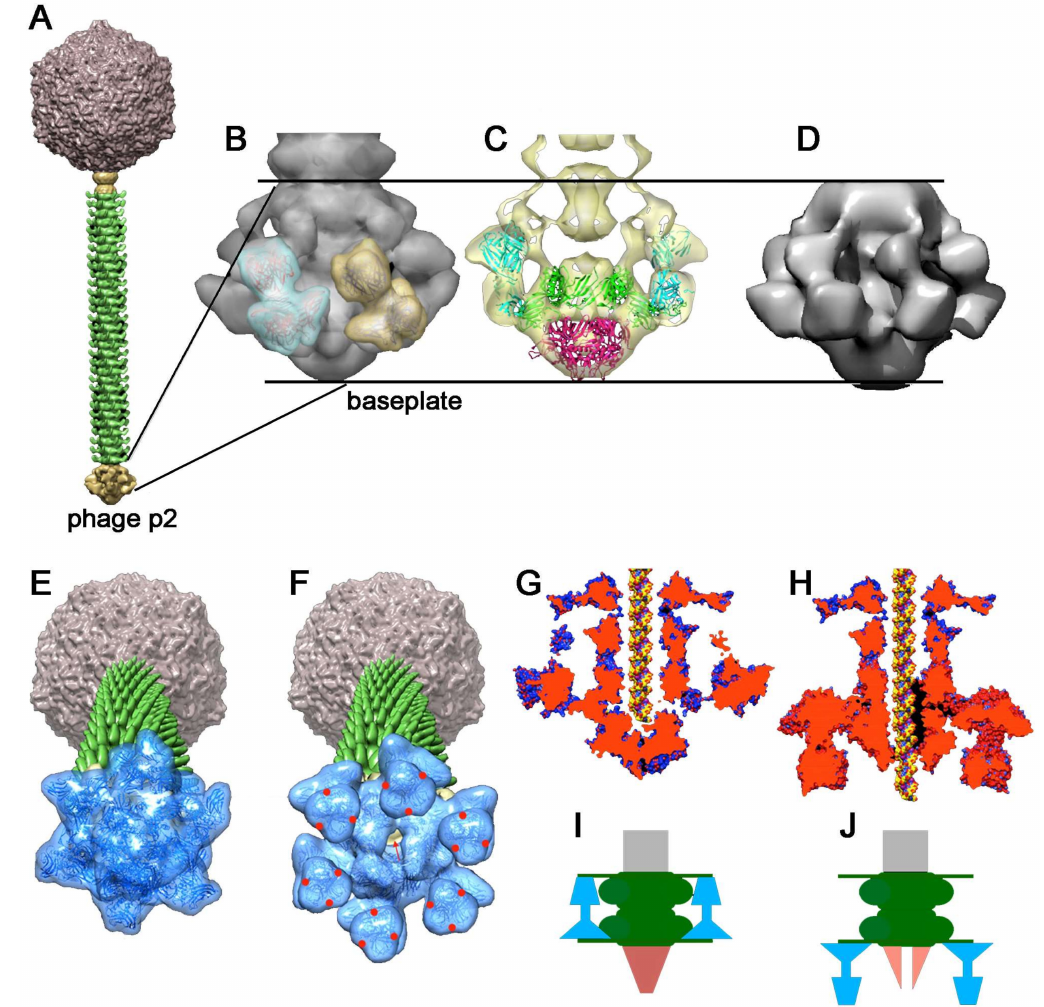
Figure 6. Structure of the activatable baseplates from siphophage p2. ( A ) negative staining EM (nsEM) structure of the phage p2 virion [92]. ( B ) Zoom on the baseplate with two RBPs fitted in the nsEM map. ( C ) Slicing of the nsEM map exhibiting the baseplate (Dits, Tals, and RBPs) fitted inside. ( D ) nsEM structure of the expressed baseplate; note the extra volume compared to the X-ray structure obtained in the presence of VHHs [24]. ( E ) Representation of phage p2 with the non-activated baseplate. ( F ) Representation of phage p2 with the X-ray determined activated baseplate localized at the tail extremity. The red arrows show the open Tal channel and the red dots the position of the receptor binding crevices. ( G , H ) sliced views of the structures shown in ( E )- and ( F )-, respectively. A model of dsDNA helix shown in the central closed or open channel. ( I , J ) schematic representation of the phenomenon associated with baseplate